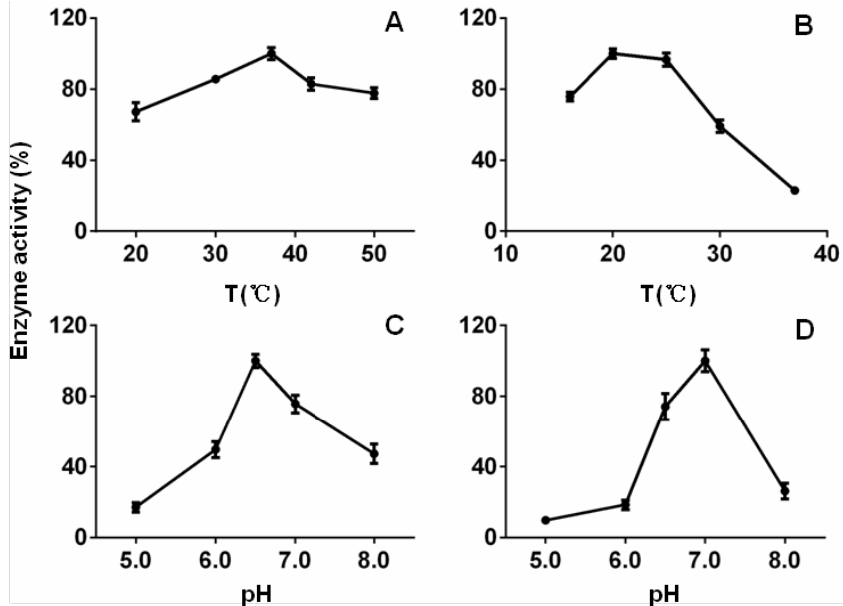
Figure 4. The optimal temperature and pH for the activity of recombinant DBRs. The effect of ( A , B ) temperature, ( C , D ) pH on ( A , C ) recombinant MpDBR, ( B , D ) recombinant MpMDBRL. All reactions contained caffeyl aldehyde. Data are shown in the form mean ± SD ( n = 3).